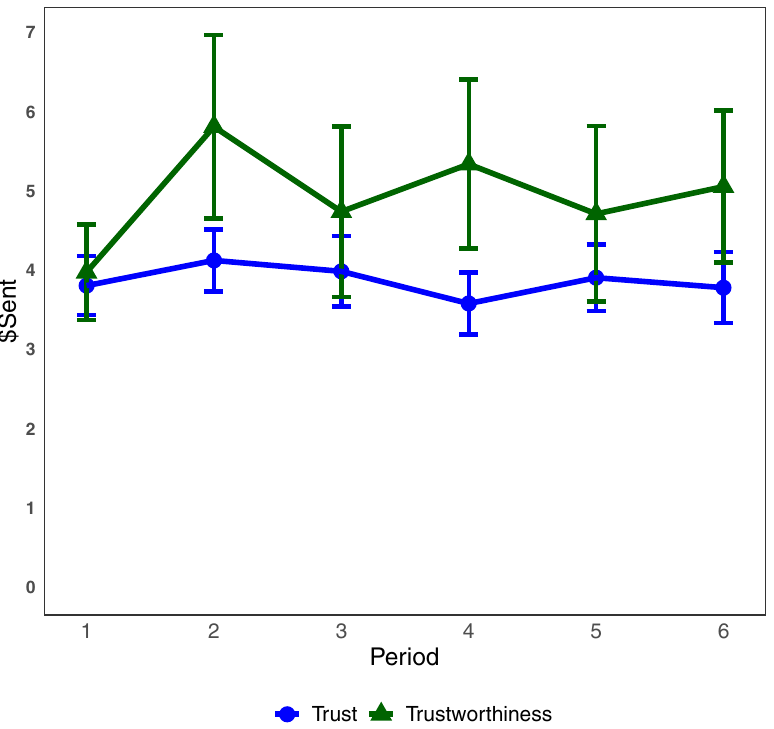
Figure 2. Average amount sent (Trust) by senders and average amount sent back (Trustworthiness) by receivers per round. Vertical lines represent standard errors. Endowment for buyers/sellers was $6.67, average amount received by receivers (after being multiplied) was $11.59.